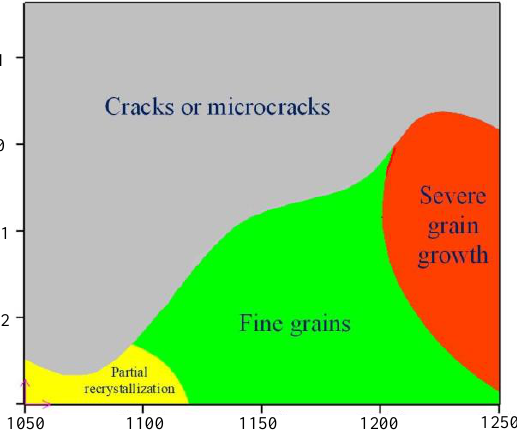
Figure 19. Microstructure of X12 alloy steel under various deformation conditions. ( a ) 1100 ◦ C/1 s − 1 (Region A); ( b ) 1150 ◦ C/1 s − 1 (Region A); ( c ) 1200 ◦ C/5 s − 1 (Region A); ( d ) 1150 ◦ C/0.5 s − 1 (Region B); ( e ) 1100 ◦ C/0.05 s − 1 (Region C); ( f ) 1250 ◦ C/0.5 s − 1 (Region D).